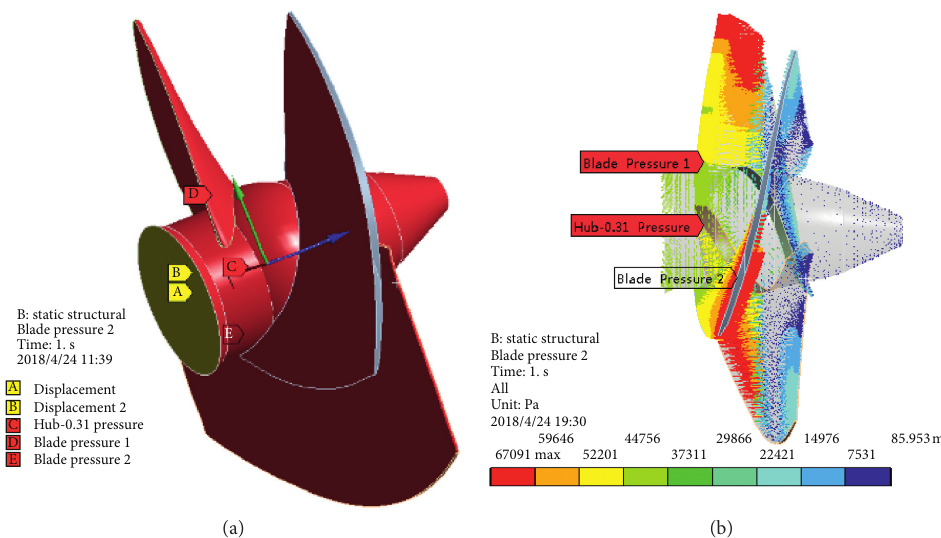
Figure 8: The boundary conditions of structural field: (a) boundary conditions; (b) water pressure loading.